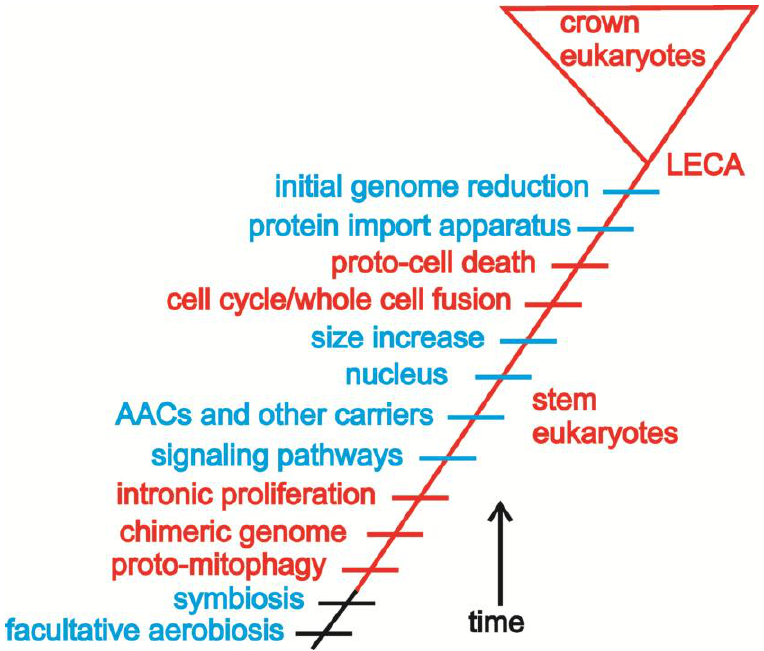
Figure 4. Based on logical assumptions, a sequence of events during eukaryogenesis is outlined. Derived characters that contribute more to conflict are highlighted in red, while those that mediate conflict are in blue. The list of characters is of course incomplete and provided only as an exemplar. (The chronological time scale for the stem eukaryotes is expanded for emphasis.)